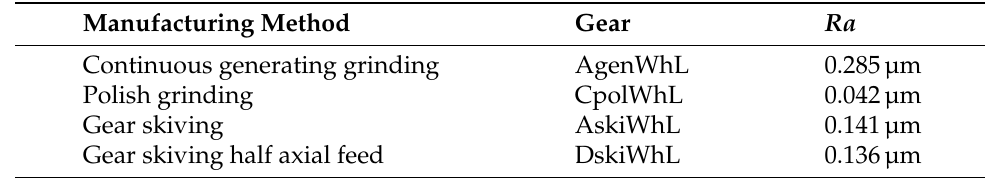
Table 6. Comparison of the flank roughness of the different manufacturing